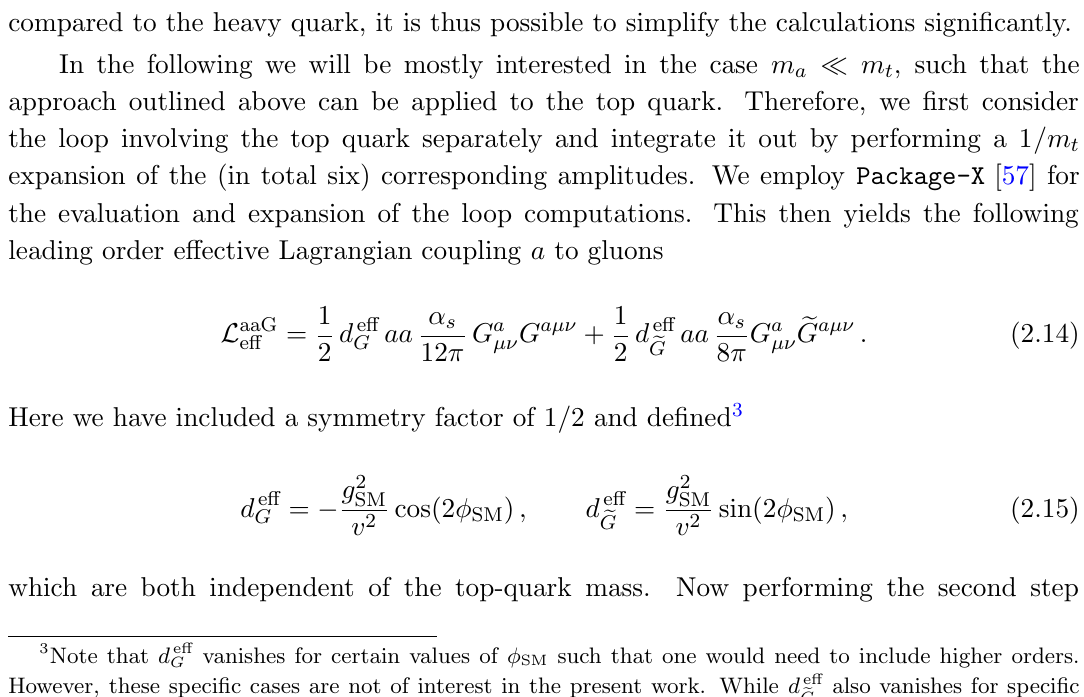
Figure 3 . Illustration of the decomposition of the two-loop process for m (cid:12)rst integrating out the heavy quark Q ((cid:12)rst arrow) one can then match the resulting one-loop diagram onto e(cid:11)ective DM-gluon interactions (second arrow). The black dot represents an e(cid:11)ective interaction corresponding to a higher-dimensional